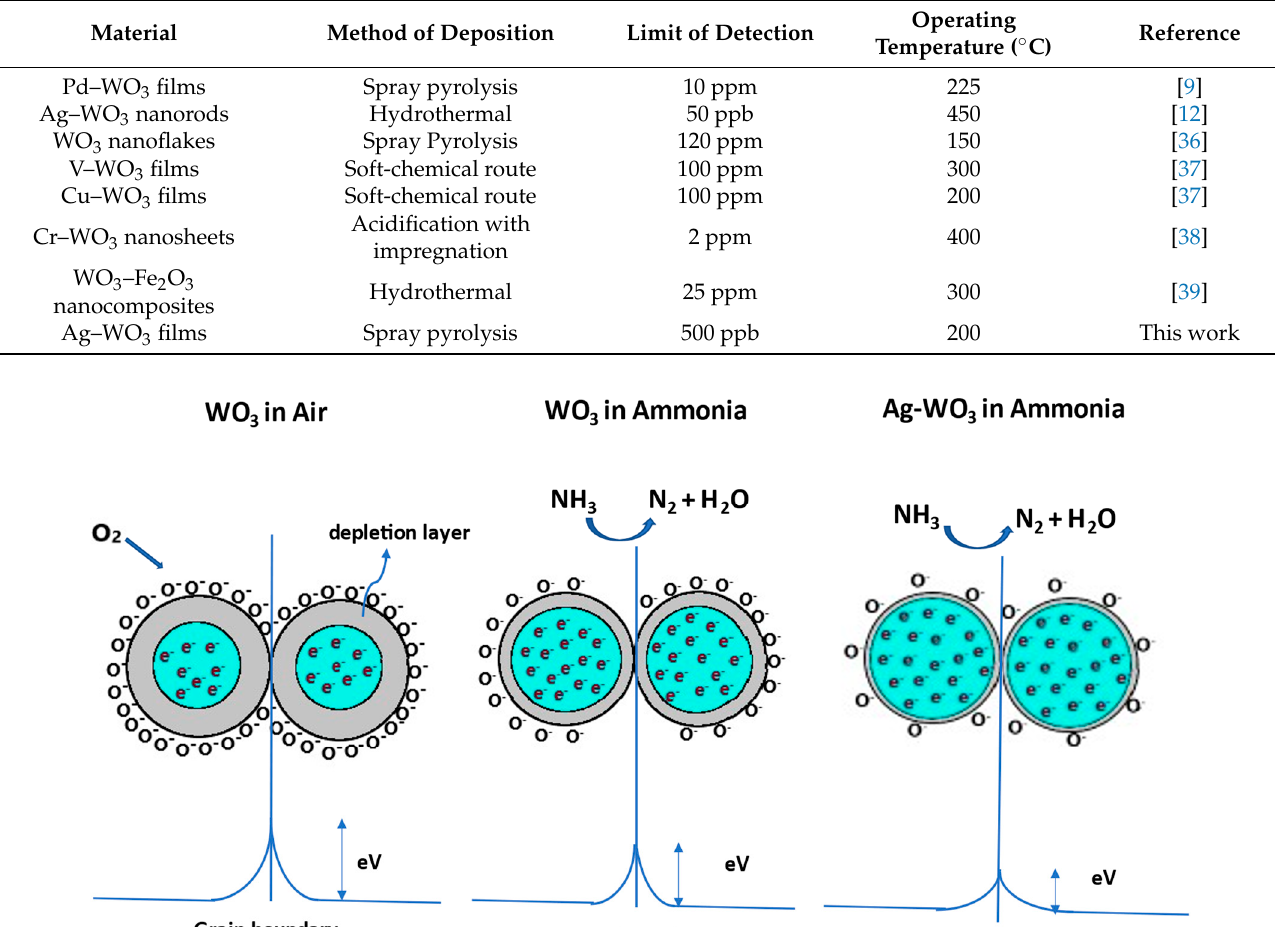
Table 2. NH 3 -sensing properties of the present work and reported in the literature.